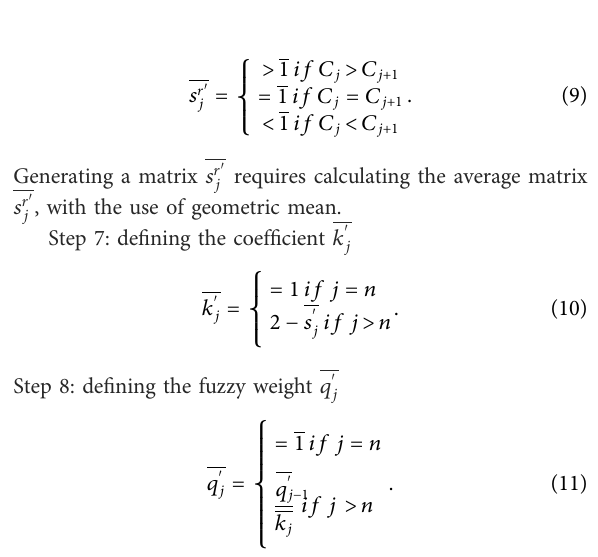
FIGURE 2 Triangular fuzzy numbers. Source: based on the study by (Bo ž ani ć et al.,